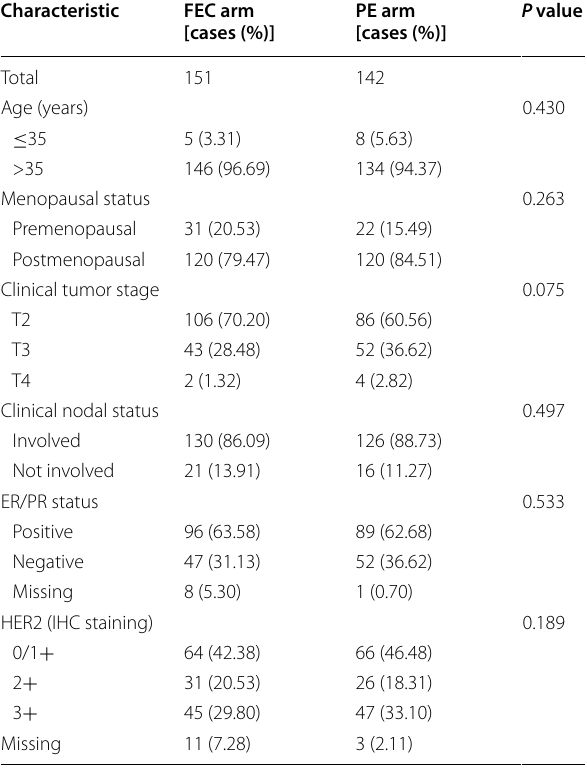
Table 1 Baseline characteristics of all enrolled patients with locally advanced breast cancer